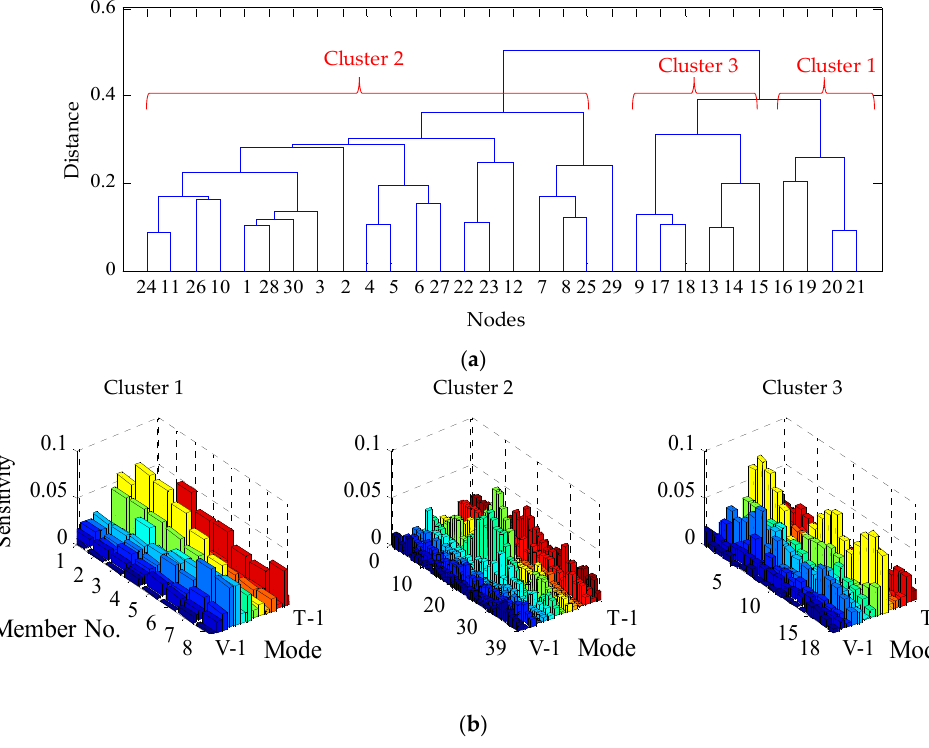
Figure 3. ( a ) Hierarchical binary tree for mass sensitivities; ( b ) Sensitivity matrices of mass clusters. The “Mode” axis indicates the first 9 vertical, 4 lateral and 1 torsional modes.